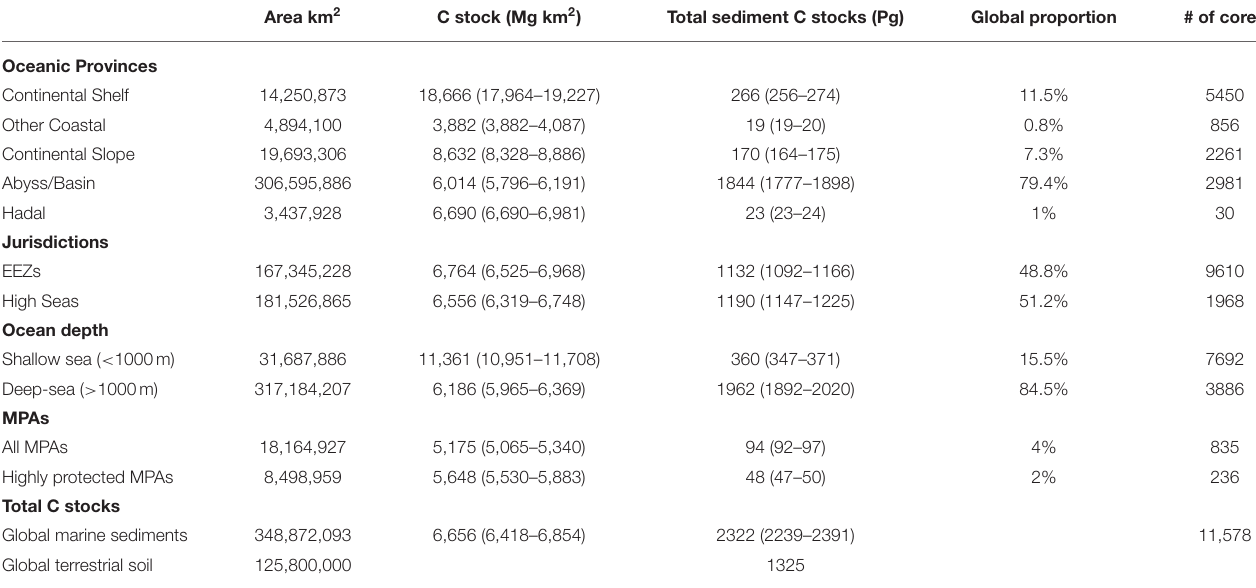
TABLE 2 | Global extent, average (95% confidence intervals) carbon (C) stocks in the top 1m, and proportion of the global marine sediment C stock in the top 1m for different oceanic provinces, marine jurisdictions [Exclusive Economic Zones (EEZ)], ocean depths, marine protected areas (MPAs), including implemented highly and fully protected areas, and total marine sedimentary C stock for the global